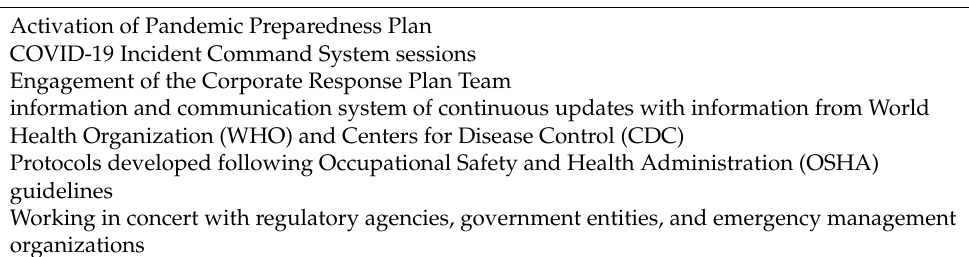
Table 1. Protocols and actions carried out by the companies during the COVID-19 pandemic. Actions and Information Available for Workers and Corporate Policy Interventions Activation of Pandemic Preparedness